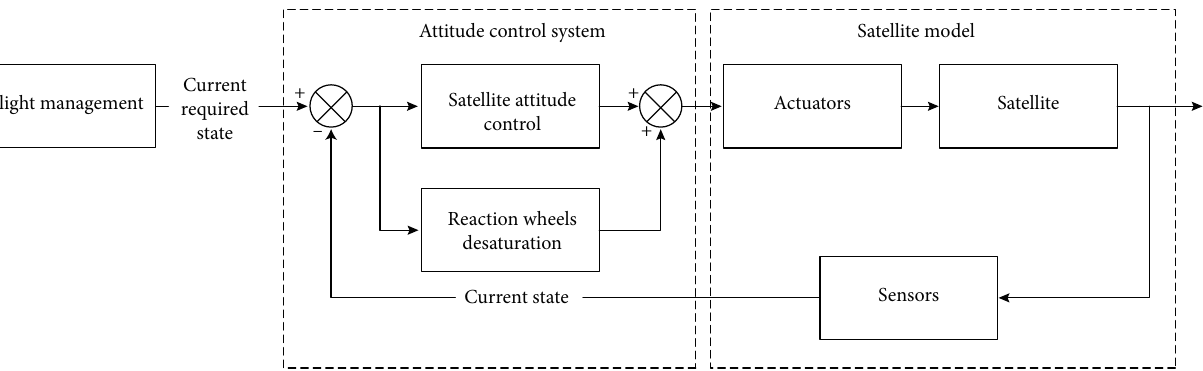
Figure 3: General architecture of the attitude control system.